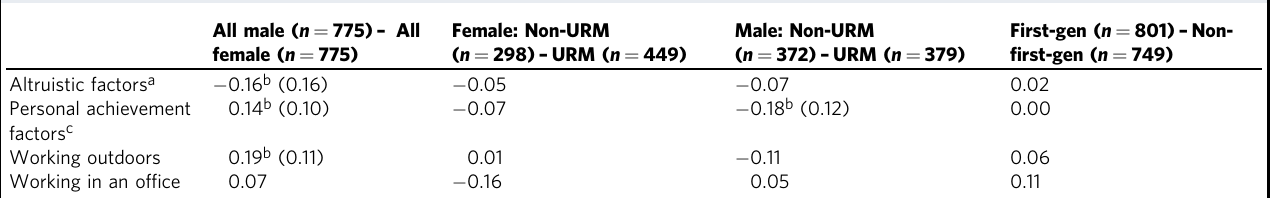
The numbers shown are the difference in the mean of groups designated. Positive numbers indicate that the fi rst group rated the question more important. When there was a signi fi cant difference betweentwo groups, an effectsize wascalculated andis shown inparentheses. Thelargerthe number, thelarger the effect.A large effectis shownby a value of 0.5,a mediumeffectby 0.3, and a small effect by 0.1 37 . a Combined “ helping people and society ” and “ helping the environment ” . b Indicates a difference signi fi cant at the 99% level between groups using Mann – Whitney U -tests. Signi fi cance levels were corrected for multiple tests using a Bonferroni correction. c Combined “ making money ” and “ having prestige ”